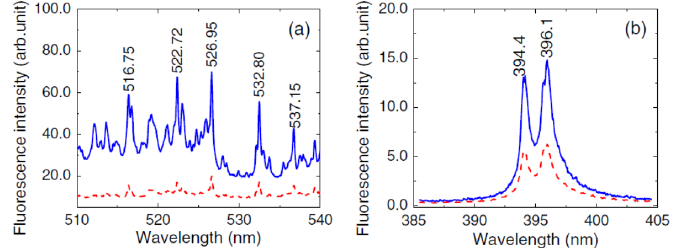
Figure 9. Filament-induced breakdown spectroscopy generated on iron ( a ) and aluminum; ( b ) targets with (blue solid lines) and without (red dashed lines) SSTF pulses. Reproduced with permission from [37], Copyright The Optical Society, 2012.